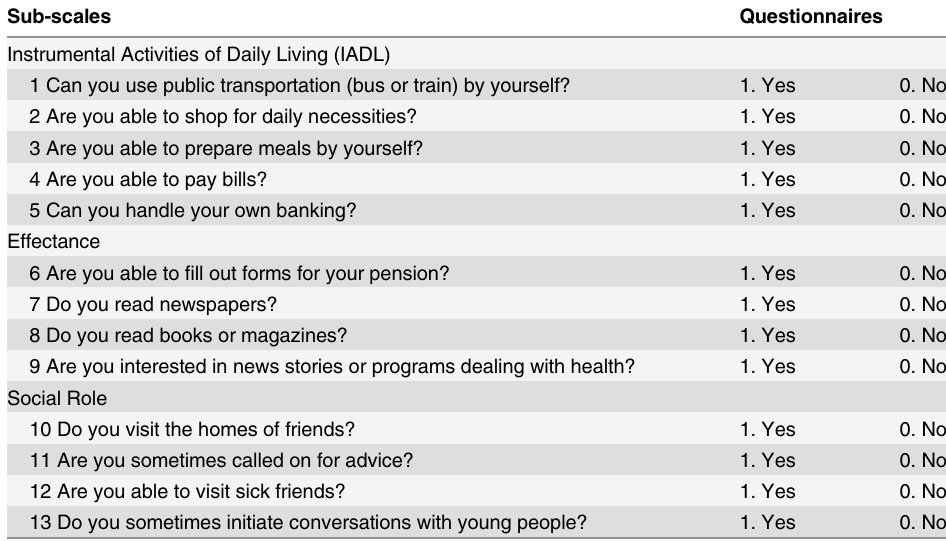
Table 2. The Tokyo Metropolitan Institute of Gerontology Index of Competence (TMIG-IC) for assess- ing higher-level functional capacity in older adults. Sub-scales